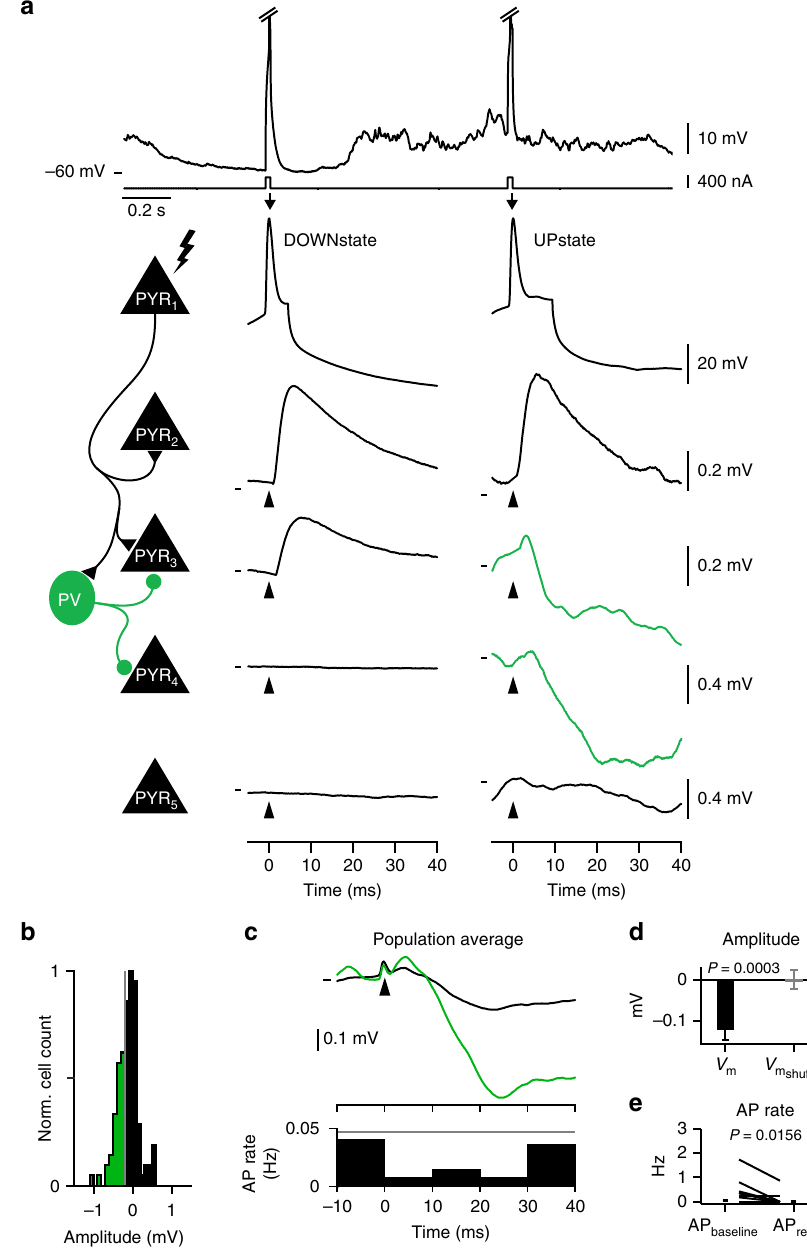
Fig. 7 Single excitatory pyramidal neuron action potentials evoke inhibition in neighboring pyramidal neurons. a Top shows example V m from a PYR neuron with current evoked APs (clipped) in DOWNstate (left) and UPstate (right), below shows zoom of example current evoked APs (PYR1). The V m response of 4 example cells are shown below PYR1, recorded in different mice, to evoked PYR neuron spikes in DOWNstate (left) and UPstate (right), showing (from top to bottom), connection with little modulation in amplitude (PYR 2 ), a connection with a depolarizing response in DOWNstate but hyperpolarizing response in UPstate (PYR 3 ), an unconnected PYR neuron with no response in DOWNstate and a hyperpolarizing response in UPstate (PYR 4 ), and an unconnected PYR neuron with no response (PYR 5 ). Cartoon summary on left shows proposed connectivity. V m marks show in DOWNstate for PYR 2 : − 60.0 mV, PYR − 59.9 mV, PYR − 64.9 mV, PYR − 63.2 mV; and in UPstate for PYR − 53.6 mV, PYR − 49.0 mV, PYR − 54.8 mV, PYR − 50.4 3 : 4 : 5 : 2 : 3 : 4 : 5 : mV. b Distribution of evoked changes in V m in 25 ms following an evoked PYR neuron AP, green shows hyperpolarizing responses. c Population V m responses of n = 113 PYR neurons triggered on the evoked PYR neuron APs. Black shows the full population average (top) and PSTH (bottom) of all tested pairs shown in b . The green V m trace shows the population average of the pairs with a hyperpolarizing response (green outlined region in b ). d Amplitude of the population PYR neuron V m response to evoked PYR neuron APs (black) and shuf fl ed control responses (gray). e Reduction in PYR neuron AP rates following single, evoked PYR neuron APs, baseline = − 30 to 0 ms, response = 0 to 30 ms, lines show individual cells, fi lled circles with error bars show mean ± s.e.m. V m mark show − 51.0